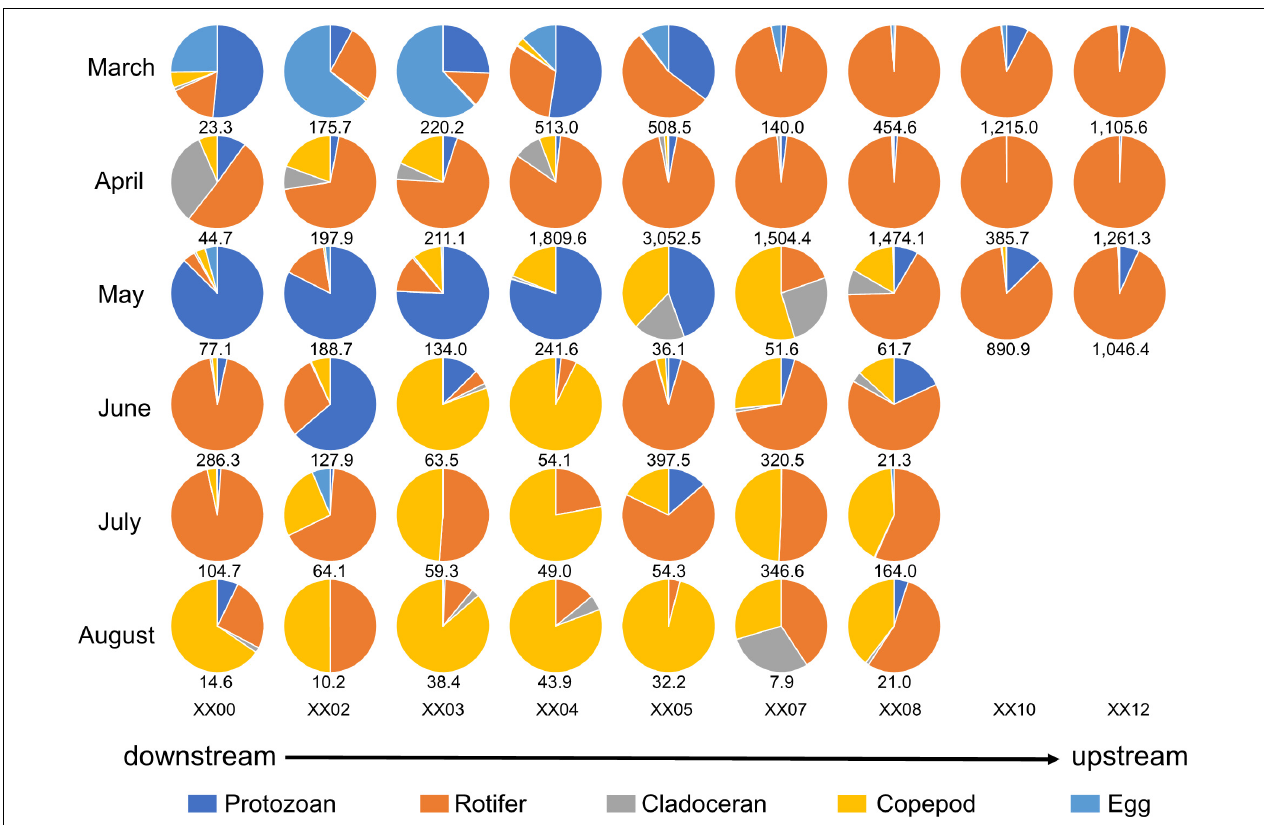
FIGURE 4 | Relative abundance of zooplankton groups in the Xiangxi Bay of Three Gorges Reservoir. Numbers under each pie represent the total abundance (ind./L) for the site.